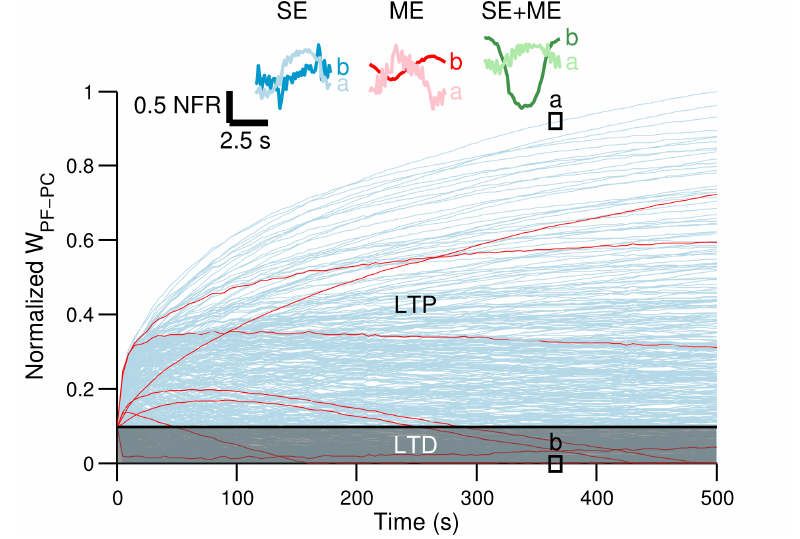
Figure 5. Synaptic weights between granule cells and the Purkinje cell ( W PF-PC ) during the control of the two-wheeled balancing robot. Red lines show some examples of W PF-PC . The horizontal line separating the shadowed areas of long-term depression (LTD) and long-term potentiation (LTP) is the initialization synaptic weight. Insets show the normalized firing rate (NFR) of granule cells whose W PF-PC synapses were predominately potentiated “a” or depressed “b” when climbing fiber (CF) carried sensory error (SE) (blue lines), motor error (ME) (red lines) or the combination of both (green